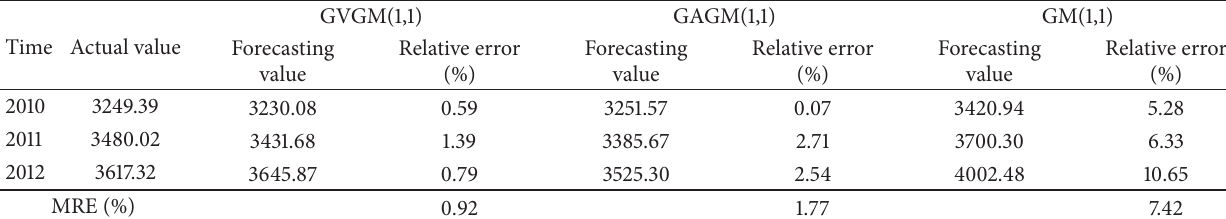
Table 2: Out-of-sample comparisons among the GVGM, GAGM, and GM models.